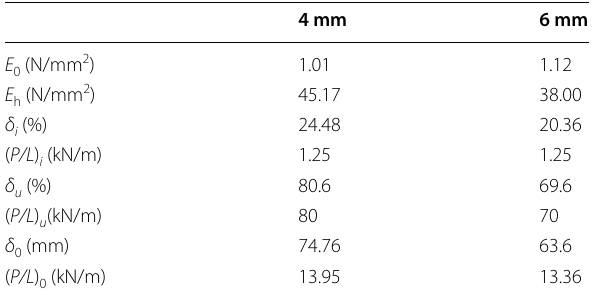
Table 1 Parameters of the bilinear stress-deformation relation